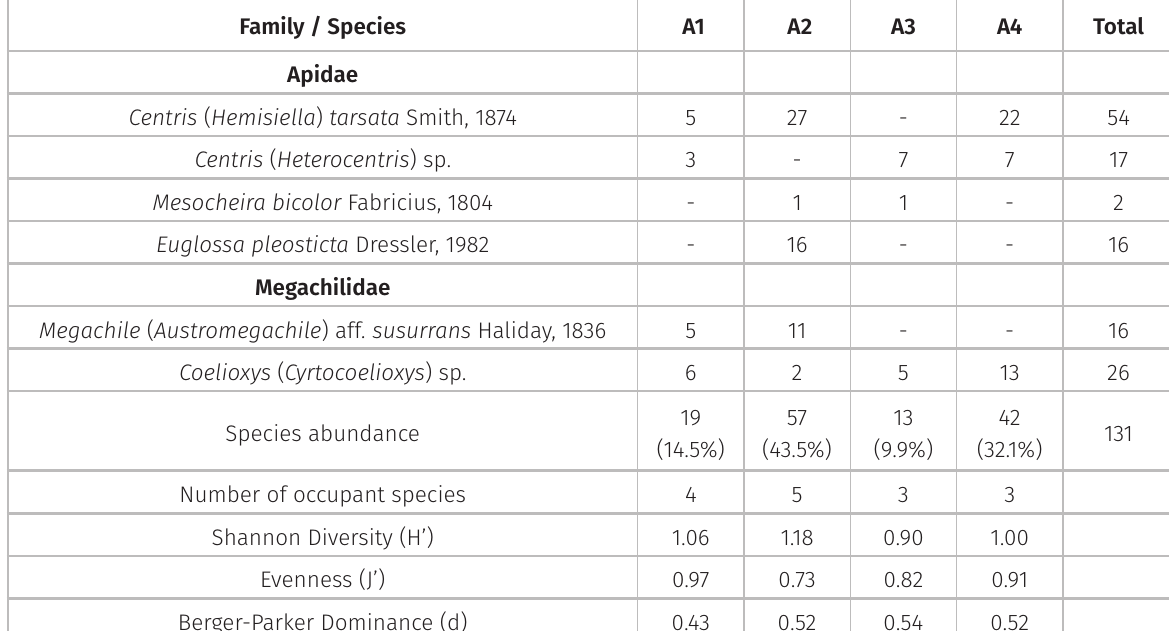
Table I. Composition, number and abundance of species (nest founders and kleptoparasites) sampled in the four studied areas; Shannon-Weaver Diversity (H’); Pielou Evenness Index (J’) and Berger-Parker Dominance (d) of